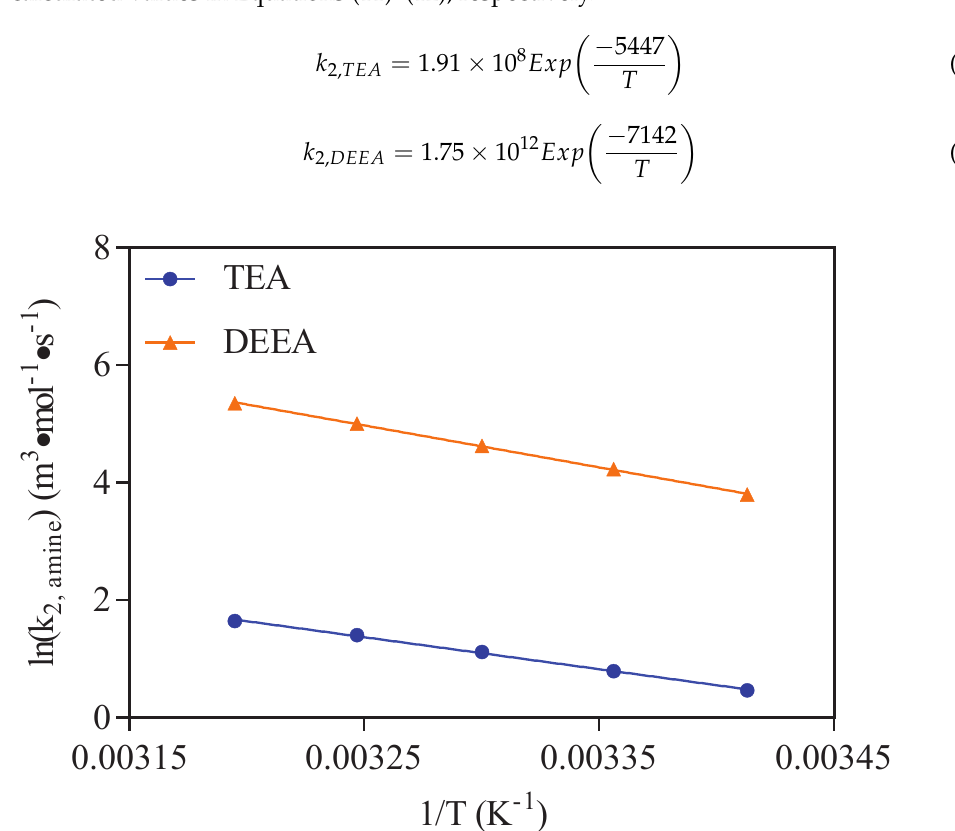
Figure 4. Plot of k 2, amine obtained by Equation (5) and Table A1 for reaction of CO DEEA solution over temperature range of 293 to 313 K.